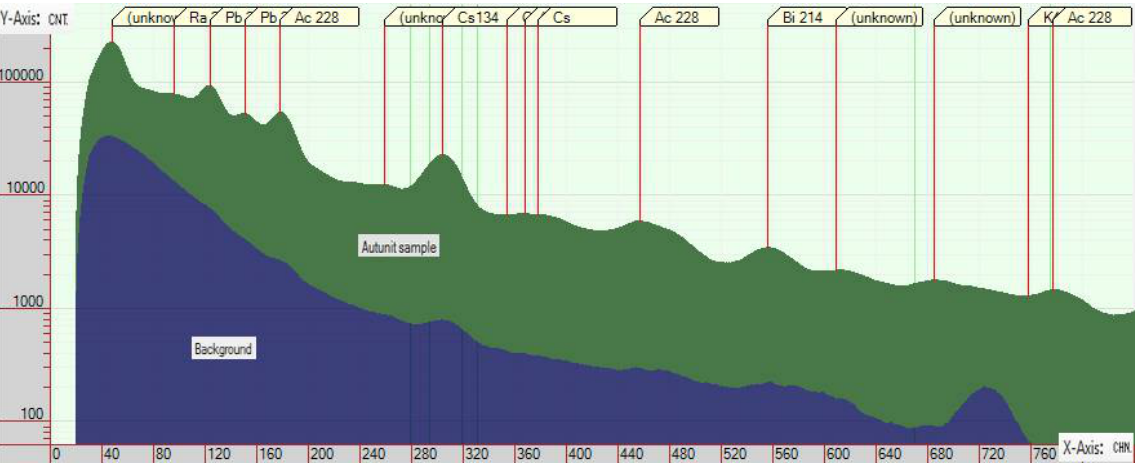
Figure 1. Comparison of the radiation spectrum measured at the test site with that of uranium ore.